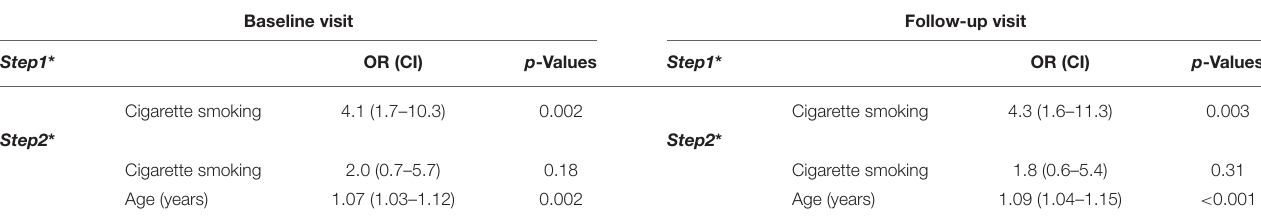
TABLE 3B | Logistic regression analysis relating rates of severe periodontal disease to cigarette smoking status and age. Baseline